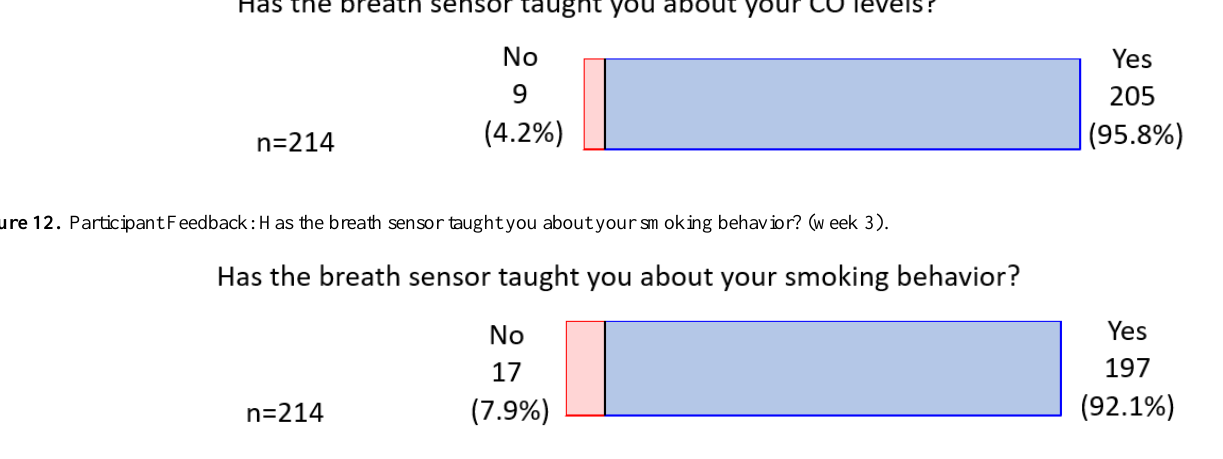
Figure 13. Participant Feedback: Understanding of CO levels and trends as they relate to smoking behavior (week 4).